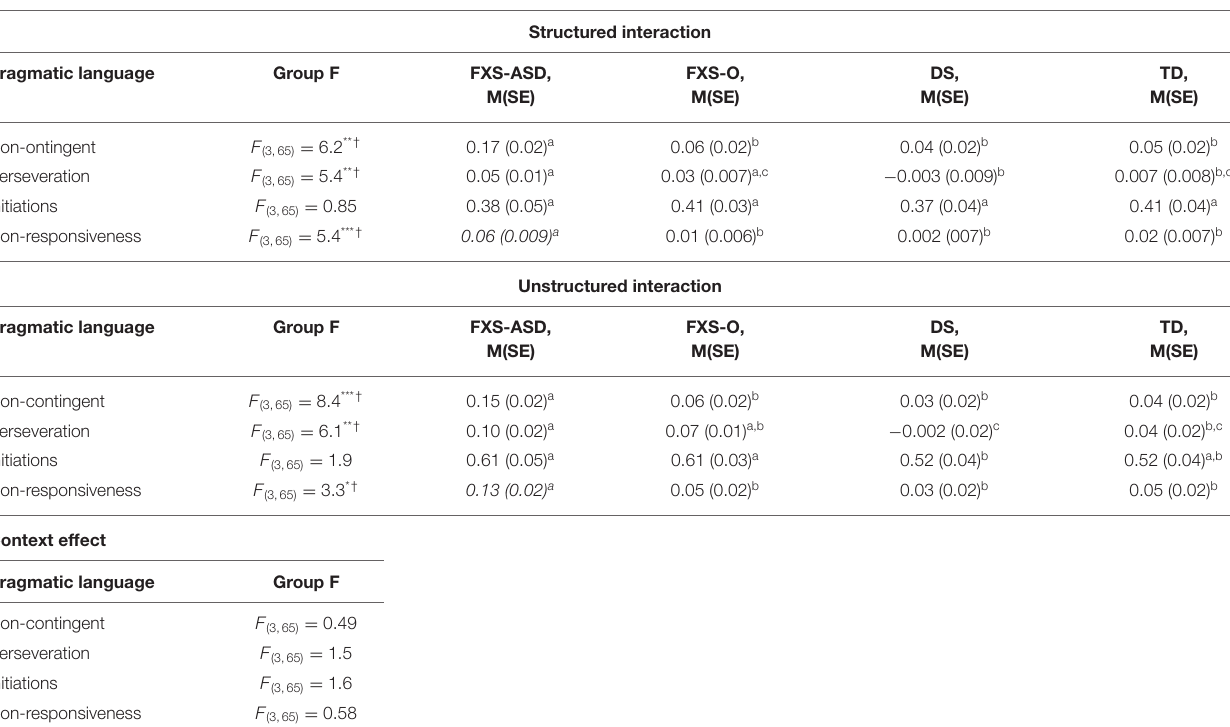
TABLE 3.2 | Group differences in pragmatic language in females.